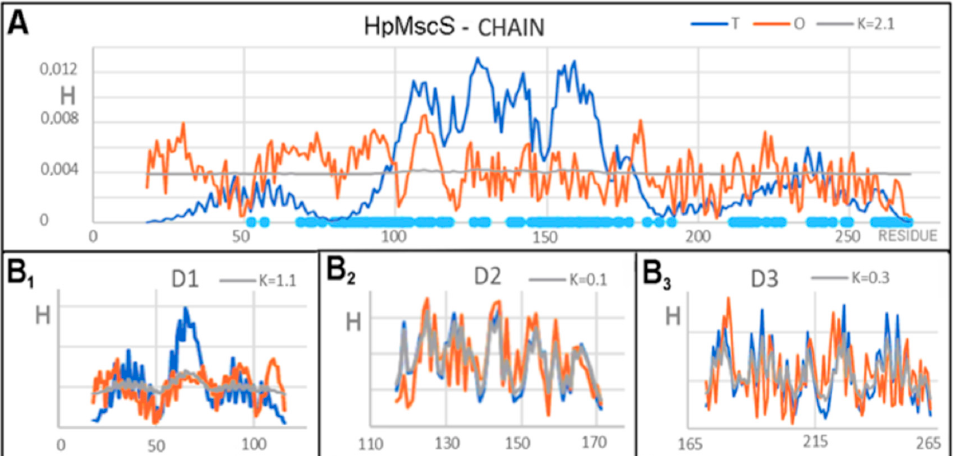
Figure 6. A set of T, O, and M profiles for ( A ) the A chain treated as an individual building unit. The light blue positions on the x axis distinguish the positions of the interchain interactions involved in the final structure of the complex; ( B ) a set of profiles for domains treated as individual structural units: ( B1 )—D1, ( B2 )—D2, ( B3 )—D3.